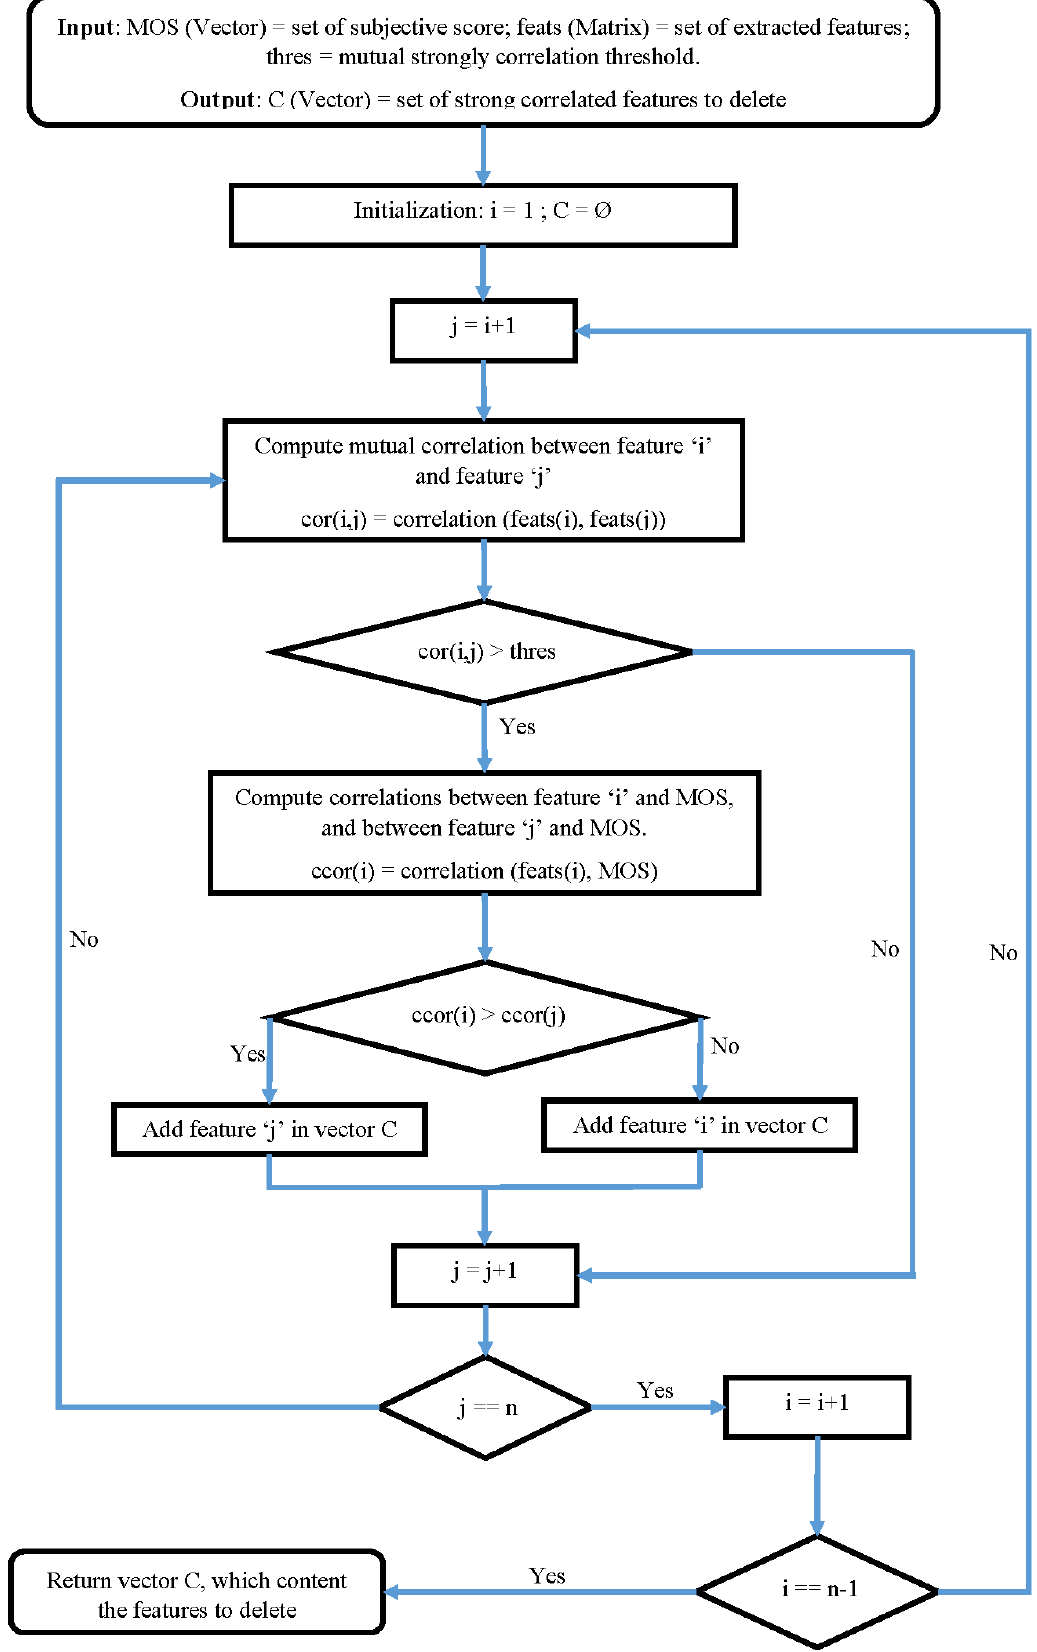
Figure 3. Flow diagram for selection of strongly correlated features to